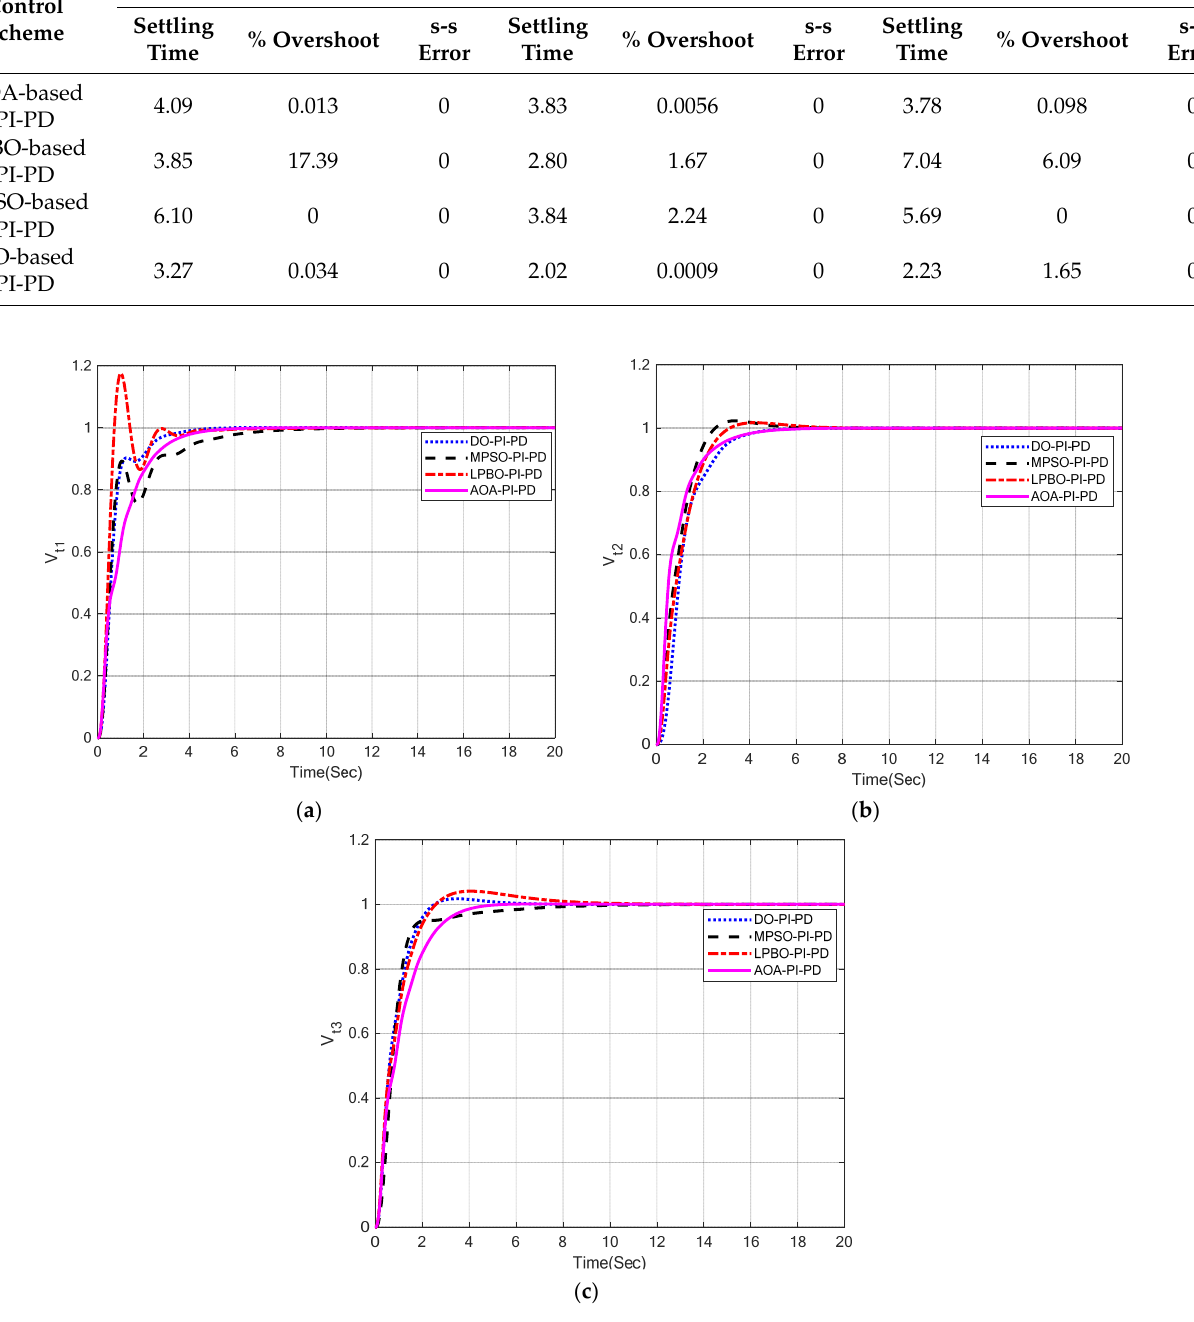
Figure 17. AVR response in a three-area multi-source IPS with nonlinearities.( a ) V t1 ; ( b ) V t2 ; ( c ) V t3 . Table 14. Numerical results of AVR in a three-area multi-source IPS with nonlinearities.